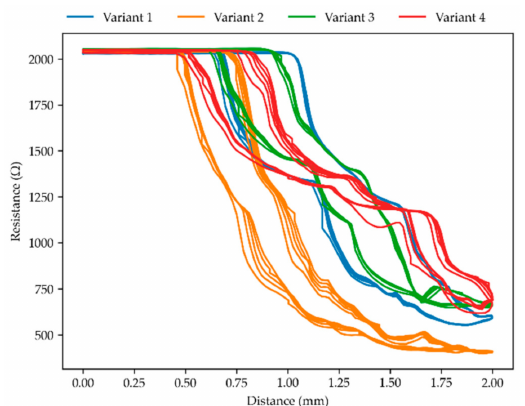
Figure 7. Resistance relation to compressed distance for measurements with a gap of 0.5 mm at 10 mm/min.